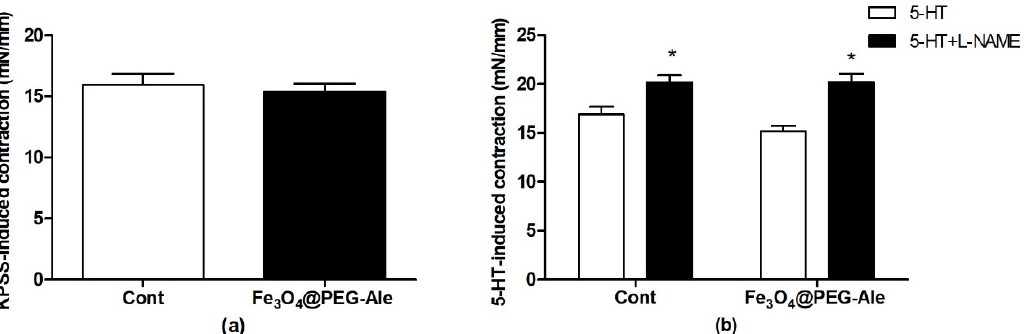
Figure 9. Maximal depolarization-induced contractions produced by ( a ) KPSS and ( b ) serotonin (5-hydroxytryptamine)- induced contractions in the absence and presence of NO synthase inhibitor L-NAME. The values represent mean ± SEM. * p < 0.05 vs. 5-HT, n = 12 per group. Cont, control; Fe 3 O 4 @PEG-Ale, Fe 3 O 4 @PEG-alendronate nanoparticles; KPSS, high concentration of potassium (125 mmol/L)-containing physiological saline solution; 5-HT, serotonin; L-NAME, N ( ω )-nitro-L-arginine methyl ester.